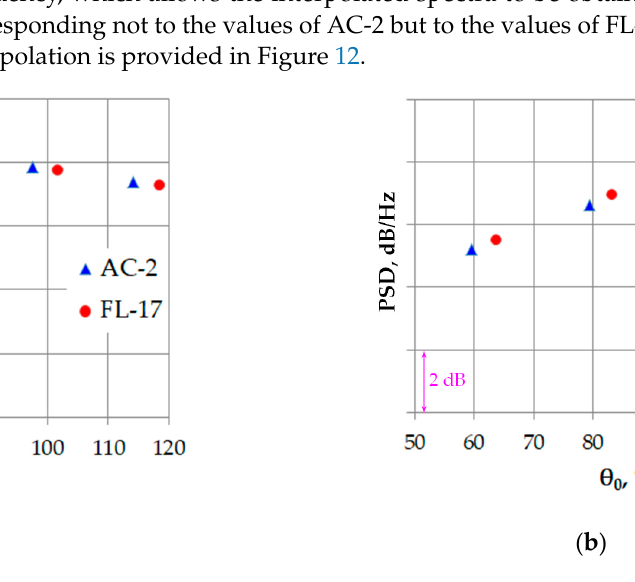
Figure 12. Interpolation of noise levels measured in AC-2 TsAGI to azimuthal angles θ 0 , corre- sponding to FL-17 CARDC for ( a ) 2000 Hz, ( b ) 12,000